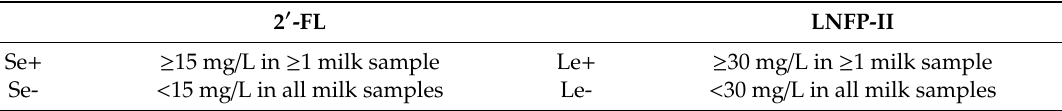
Table 1. Assignment of mothers to groups according to 2 (cid:48) -FL and LNFP-II. 2 (cid:48) -FL LNFP-II Se + Se- < 15 mg / L in all milk samples Le- < 30 mg / L in all milk